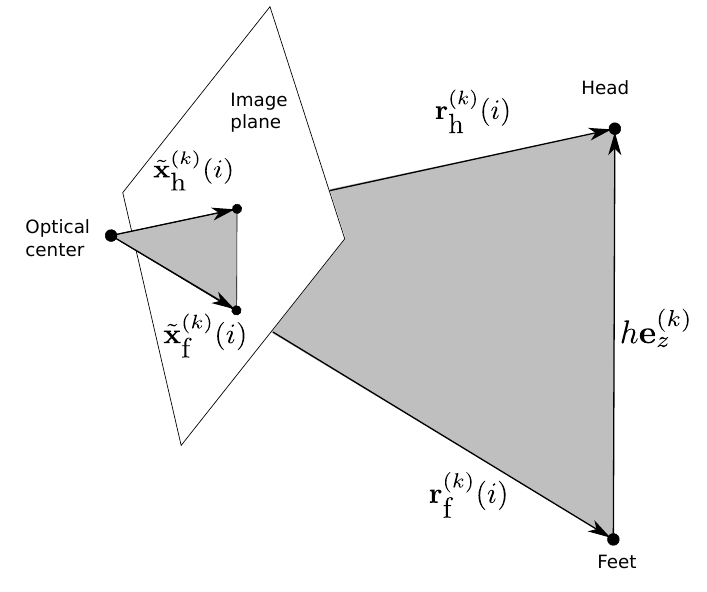
( k ) ( k ) ( i ) , r ( k ) ( i ) and h e ( k ) z . h e z remains the same while h f